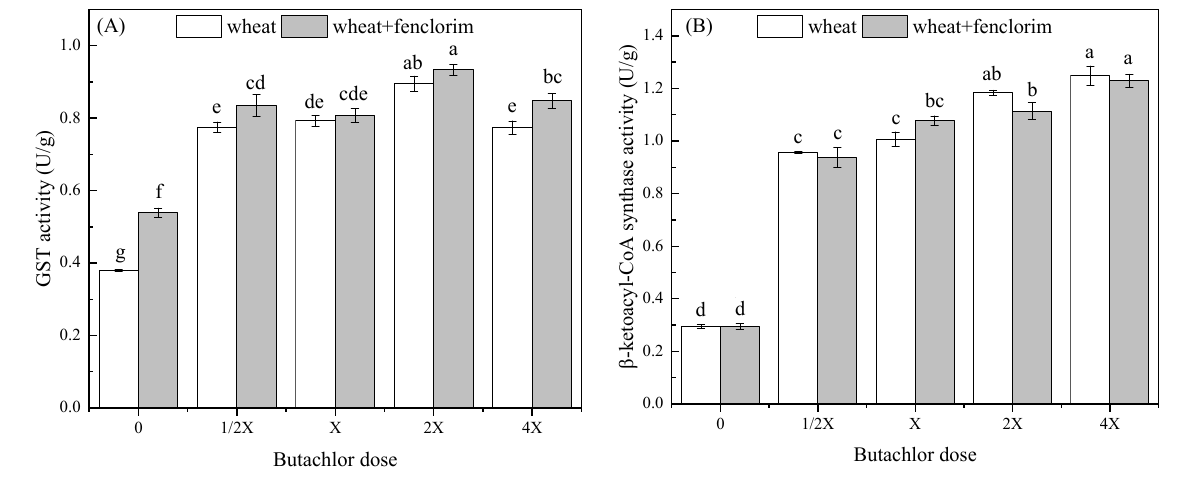
Figure 4. Activity of GST ( A ) and KCS ( B ) in wheat seeds pre-soaked 6 h in water or in 30 mg/L fenclorim solution sprayed with different butachlor doses at 24 h after treatment. X represents the recommended field dose of butachlor 1350 g a.i. ha − 1 . Each point is the mean ± SE of twice-repeated experiments, each containing four replicates. Bars designated by different lowercase letters are significantly different according to Fisher’s protected LSD at p ≤ 0.05.